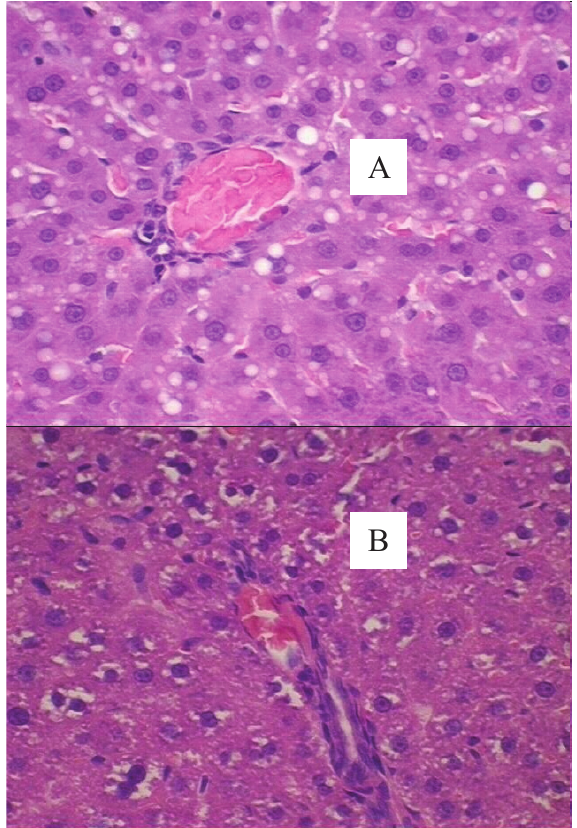
FIGURE 1 - Histological liver sections (HE, 400X). A . Hepatocytes with microvesicular steatosis (intracytoplasmic vacuoles). B . Cellular swelling (hydropic degeneration) in hepatocytes.